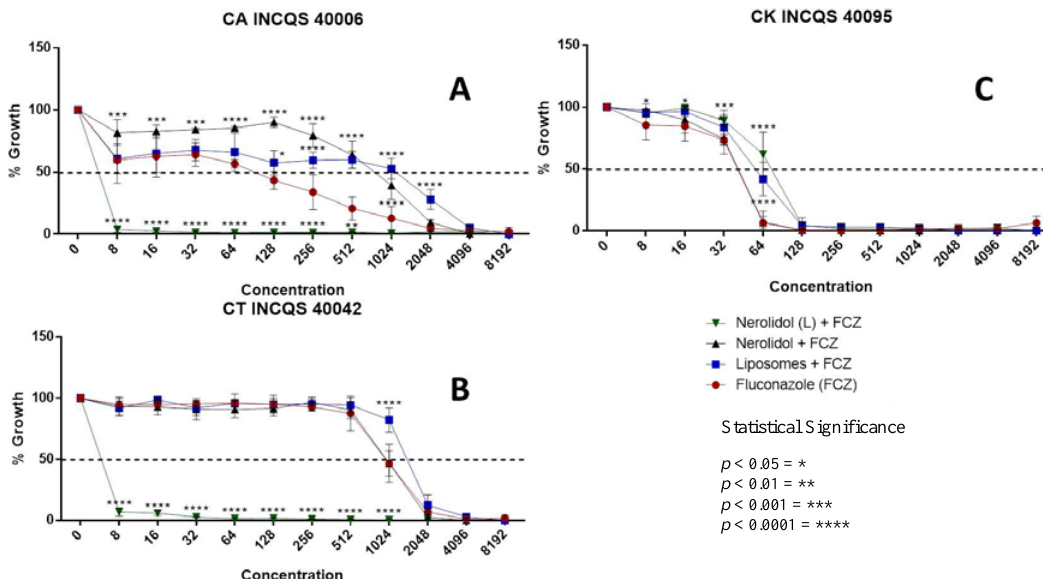
Figure 2. Growth curves of different Candida strains in the presence of fluconazole (FCZ) alone or in association with nerolidol, liposomal nerolidol (L) or liposomes. ( A ) CA— Candida albicans ; ( B ) CT— Candida tropicalis ; ( C ) CK— Candida krusei; INCQS—National Institute for Quality Control in Health. Table 2. IC 50 values (μg/mL) of fluconazole associated with nerolidol against Candida strains. Treatment